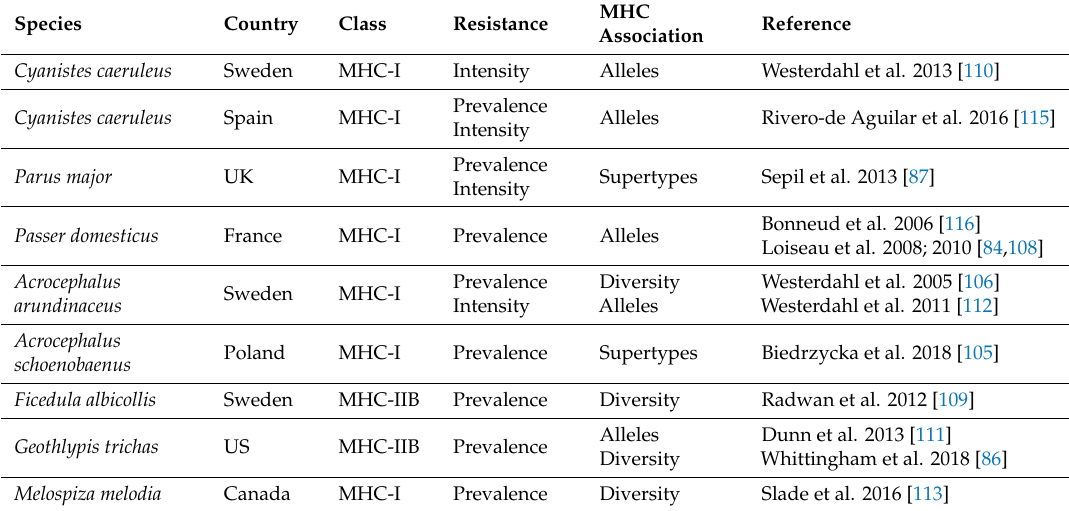
Table 2. Results of studies that have investigated the association between MHC and avian malaria. Resistance may be qualitative, whereby the malaria infection is cleared (prevalence), or quantitative, whereby the infection intensity is suppressed (intensity). Associations have been found between malaria and either specific MHC alleles, groups of MHC alleles that share similar antigen binding properties (‘supertypes’) or overall MHC